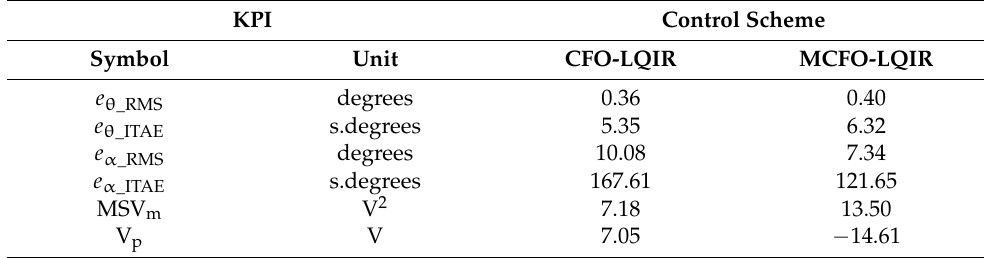
Table 3. Summary of experiment to compare MCFO-LQIR with CFO-LQIR. KPI Control Scheme